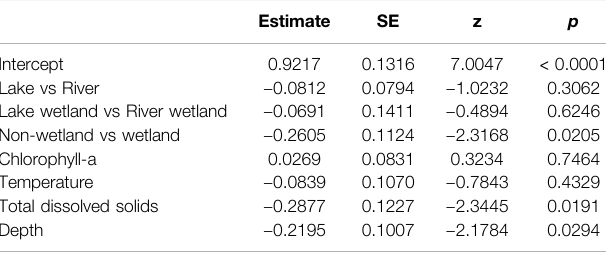
TABLE 5 | Fixed effects from the statistical model of species richness within Mildred Island, Sacramento-San Joaquin River Delta, California. Estimate SE p Intercept